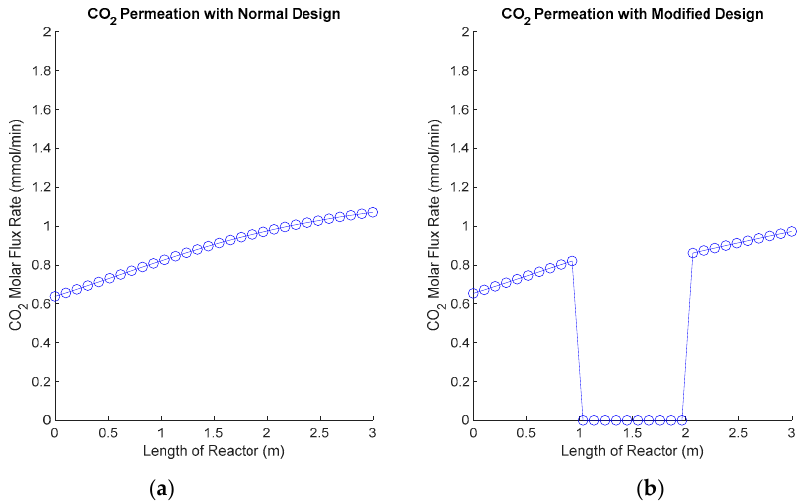
Figure 15. ( a ) Flux profile for the original design showing the continuous permeation of CO 2 out of